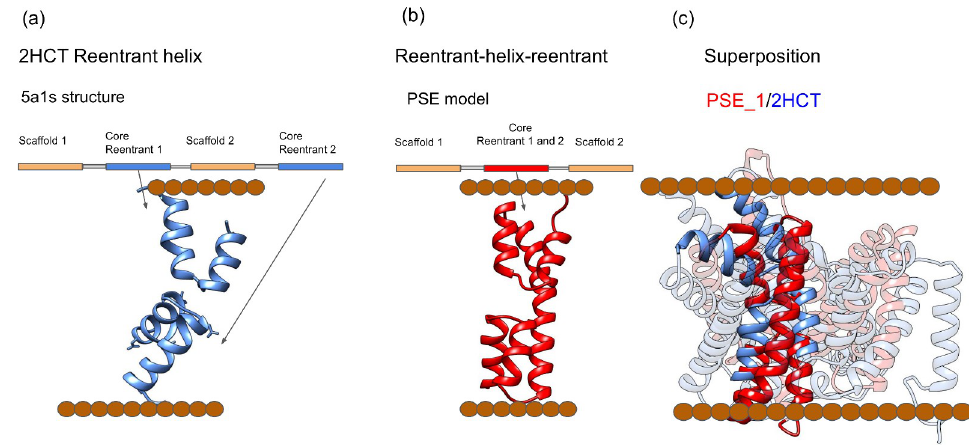
Fig 2. Comparison between PSE_1 (Reentrant-helix-reentrant fold-type) and 2HCT (CPA-reentrant fold-type). The brown dots represent the localization of the membrane a) An example of an internal symmetry with two reentrant helices (2HCT:5a1s). b) PSE_1 model. c) Superposition between the models of PSE_1 (red) and the 2HCT structure (blue).